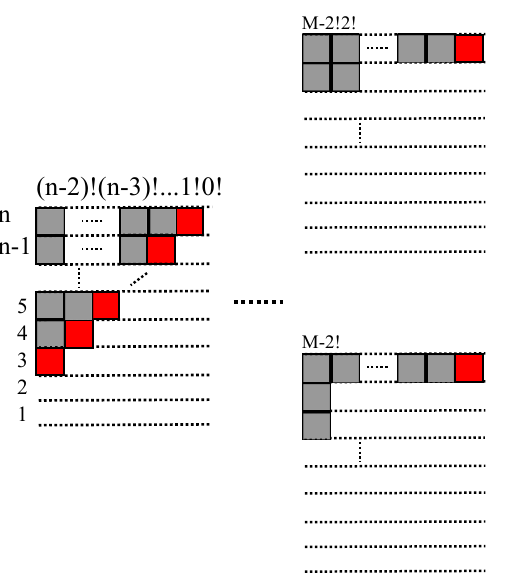
Figure 6 . The tableaux of the non-zero a ’s for the prepared form in n -point